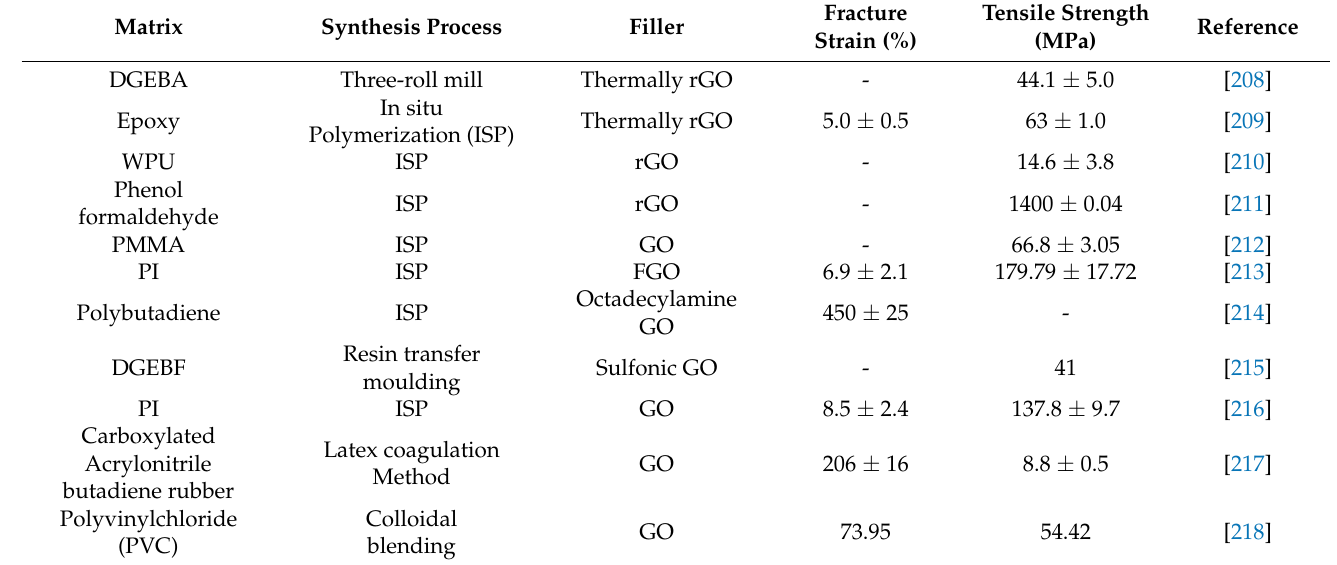
Table 1. Mechanical characteristics of graphene and graphene-based